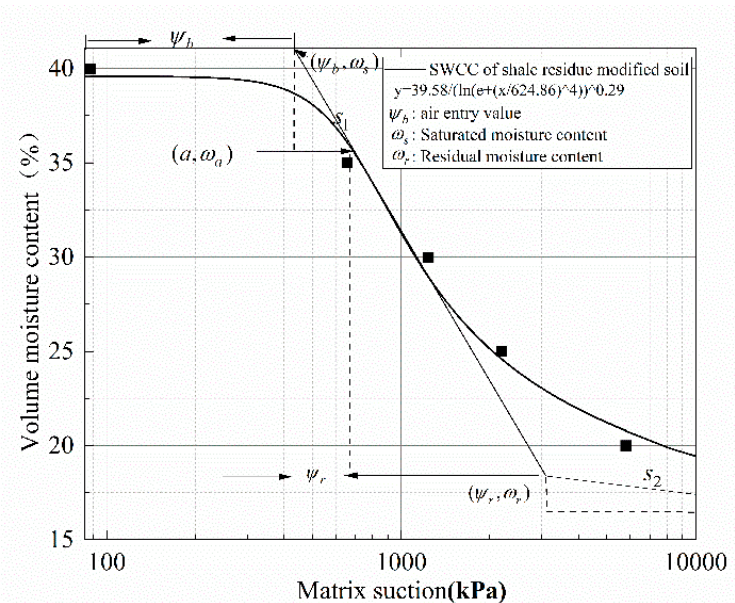
Figure 1. Soil–water characteristic curve of compacted modified